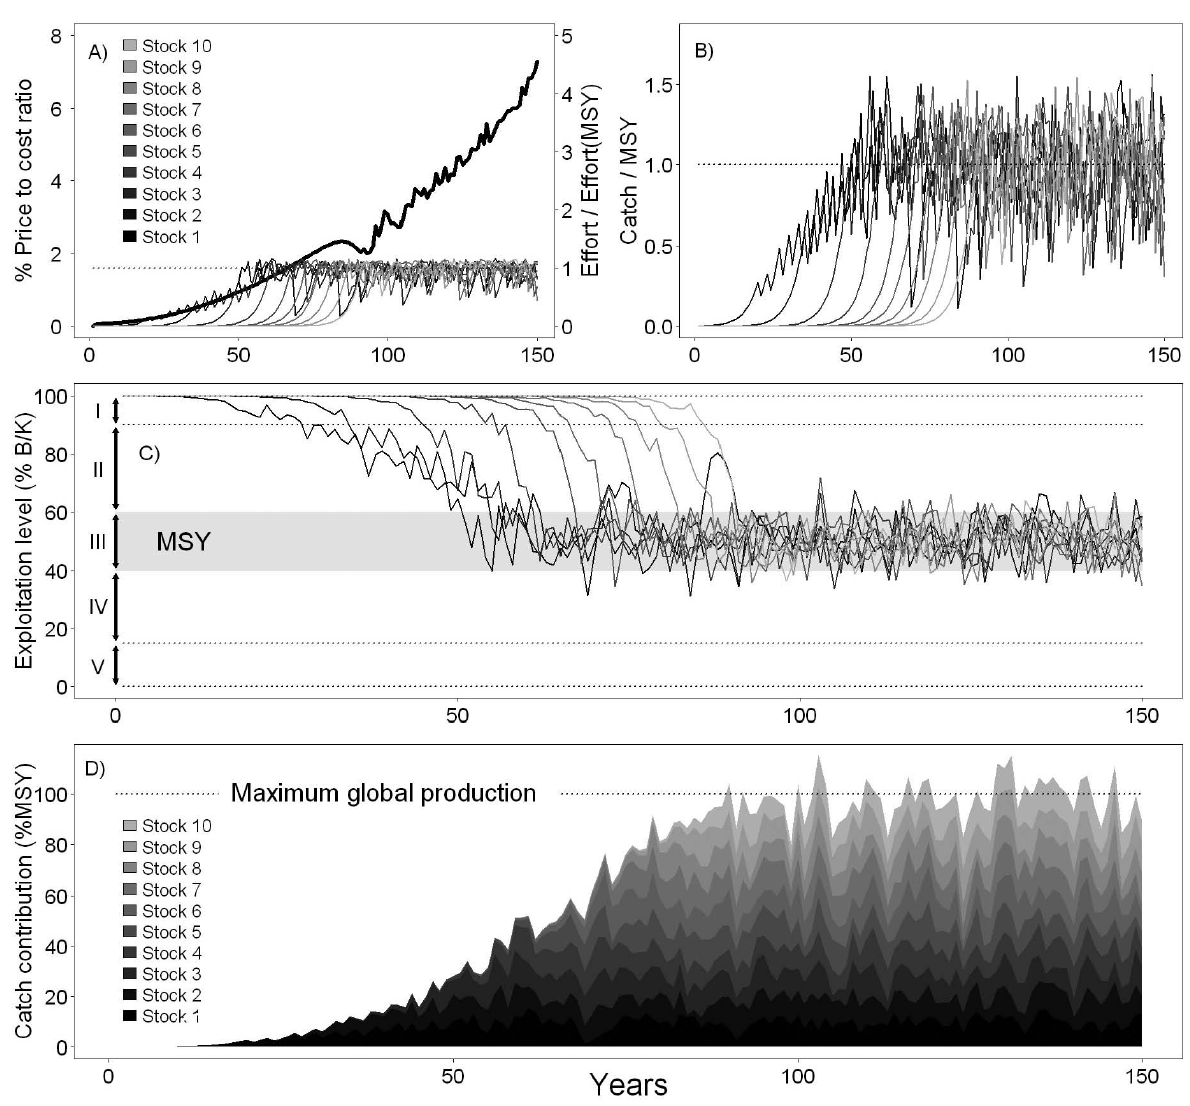
Fig . 5. – Dynamics of the global fisheries over a 150-year simulation, driven by an increase in the demand for marine commodities, market equilibrium and environmental (production) fluctuations, and managed adaptatively to drive stocks to B levels. A) Price of the marine MSY commodity as a function of its production cost (thick line), representing the change in demand (averaged for the 10 fisheries). The fishing effort applied by regional fisheries in their fish stocks in relation to the effort that would produce maximum sustainable catches is shown in thinner grey shades. Dotted line represents the effort that would produce maximum sustainable catches. B) Regional fisheries catch in relation to their MSY values over 150 years. MSY is indicated by a dotted line. C) Available biomass in the regional stocks, in relation to their pristine levels, and indication of the exploitation phases for each stock (I, Pre-development; II, Growth; III, Full exploitation; IV, Overexploitation; V, Collapse; VI, Recovery). Grey region indicates maximum sustainable yield obtained when the available biomass is nearly 50% of the carrying capacity. D) Global fisheries production in 150 years in relation to their potential maximum, which is achieved when the 10 fisheries are fully exploited. The maximum global production is thus related to the maximum potential productivity of marine ecosystems in stable